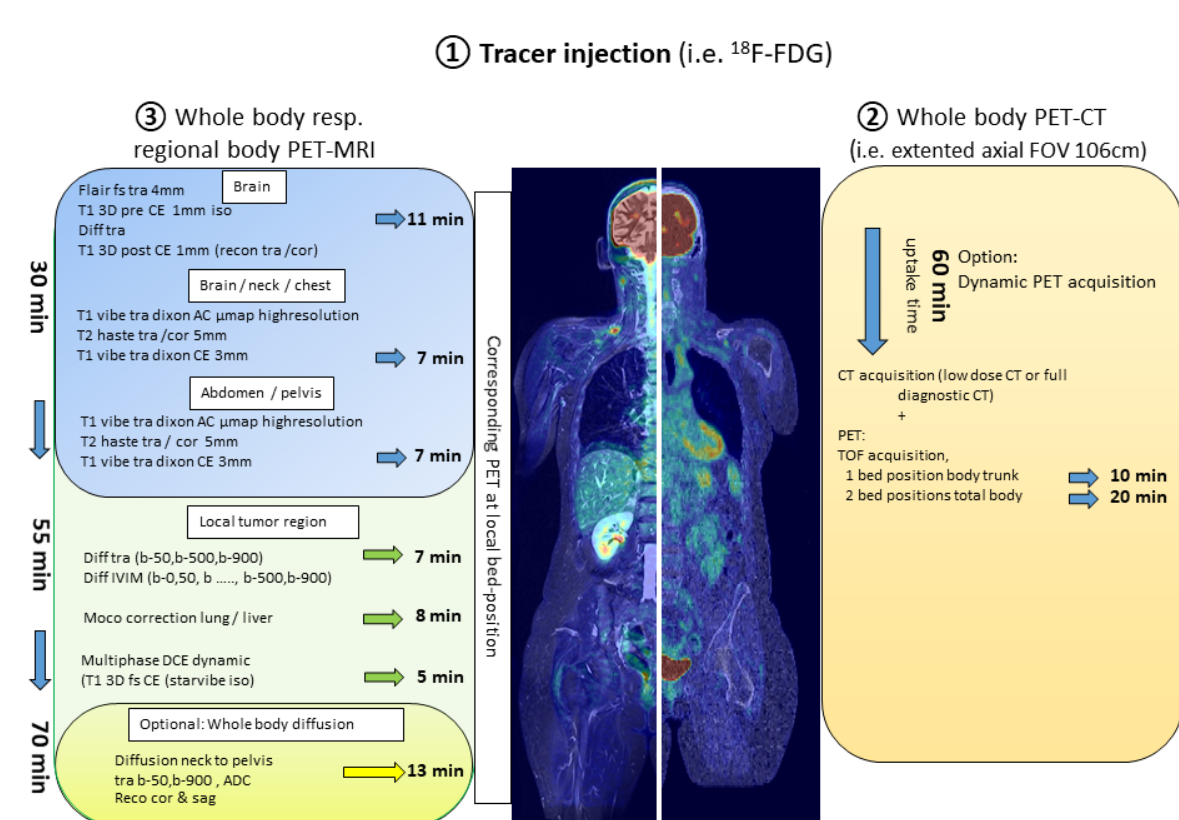
Figure 1. Components of a “multi-hybrid-imaging” oncological protocol combining PET-CT and PET-MRI with one single application of the radiopharmaceutical. The examination protocol would begin with an initial whole-body PET-CT lasting between 10 and 20 min (right side of the figure) followed by PET-MRI. PET-MRI can be performed with a fast whole-body acquisition completed within less than 30 min (upper part of the image depicting the PET-MRI protocol—blue background). To significantly take advantage of the MR-component, local PET-MRI imaging of defined body regions lasting approximately 20 min (middle part of the image depicting the PET-MRI protocol—green background) can be added. Finally, the PET-MRI examination can be further expanded with the generation of DWI of the body trunk with a minimum acquisition time of 13 min (lower part of the image depicting the PET-MRI protocol—yellow background).